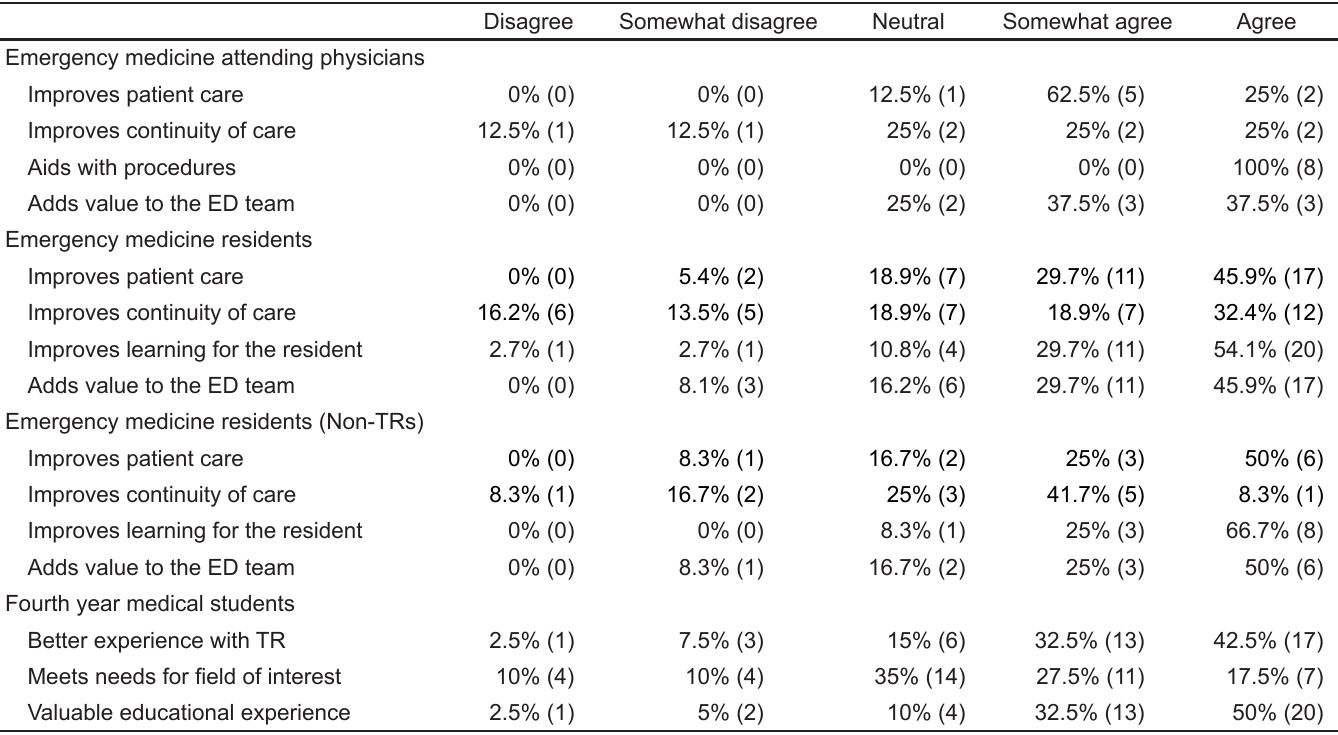
Table 2a. Subject agreement with characteristics of the teaching resident (TR) position and its effects on the emergency department (ED) - overall view. Values reported as percentage (absolute number) of responses in each response option.